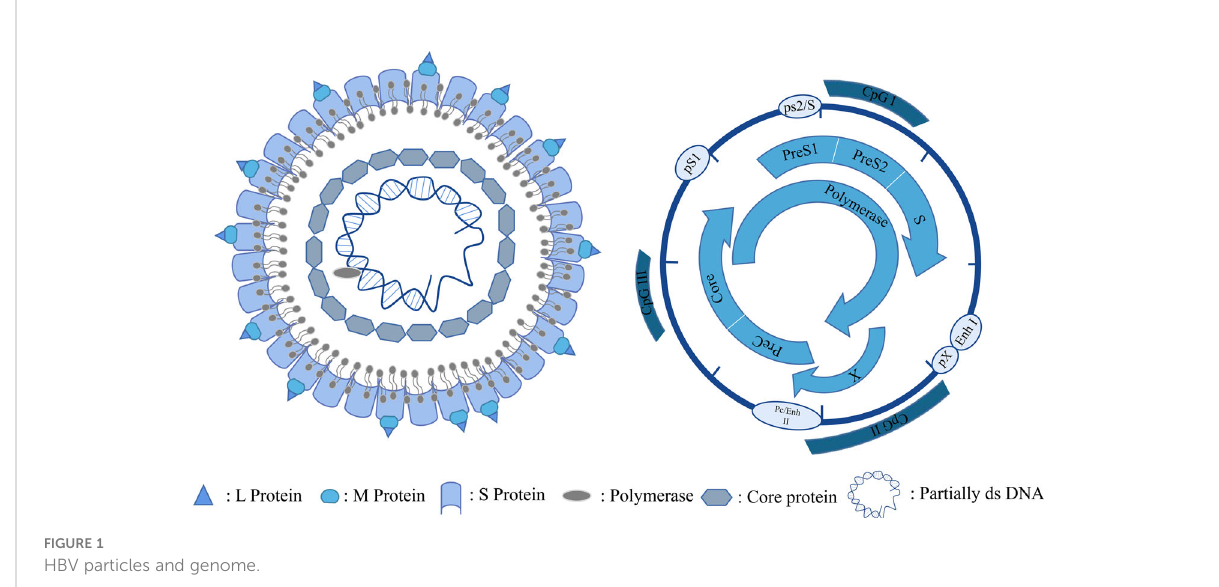
FIGURE 1 HBV particles and